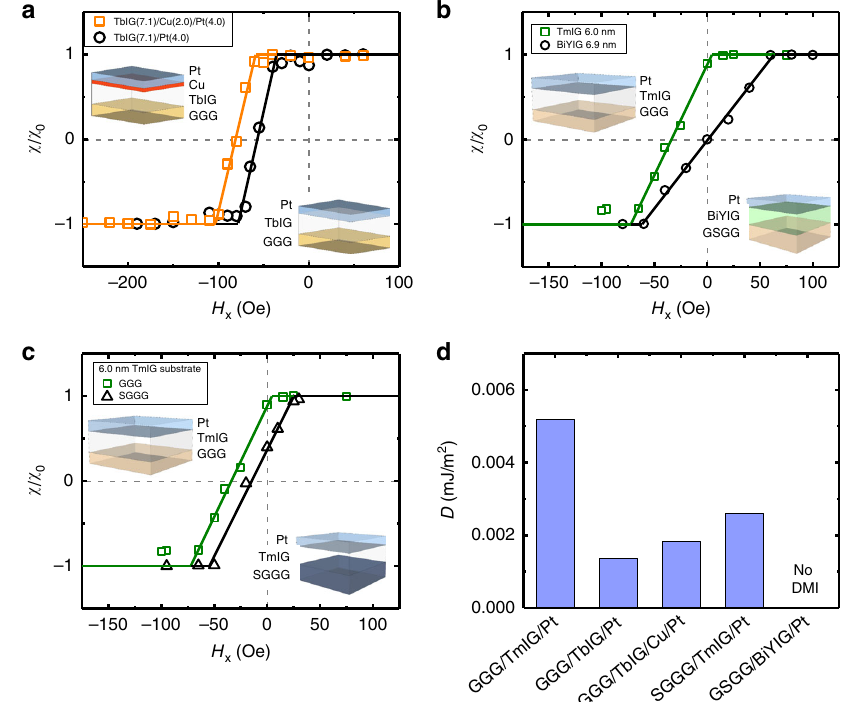
Fig. 4 In-plane fi eld dependence of the spin Hall ef fi ciency in Pt-covered insulating magnetic garnets. Normalized spin Hall ef fi ciency ( χ / χ 0 ) performed on up-down domain walls in a GGG/TbIG (7.1 nm)/Pt (4.0 nm) and GGG/TbIG (7.1 nm)/Cu (2.0 nm)/Pt (4.0 nm), b GGG/TmIG (6.0 nm)/Pt (4.0 nm) and GSGG/BiYIG (6.9 nm)/Pt (4.0 nm), and c GGG/TmIG (6.0 nm)/Pt (4.0 nm) and SGGG/TmIG (6.0 nm)/Pt (4.0 nm). Insets are layer schematics of each thin fi lm system. d Summary of DMI ( D ) strengths in each system in a – c